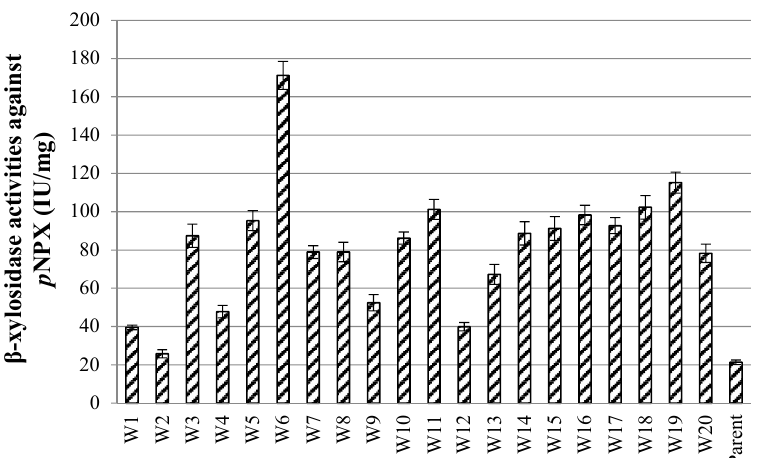
Figure 2. β -xylosidase activity of the screened mutants via the droplet-based microfluidic ultrahigh- throughput screening technology.